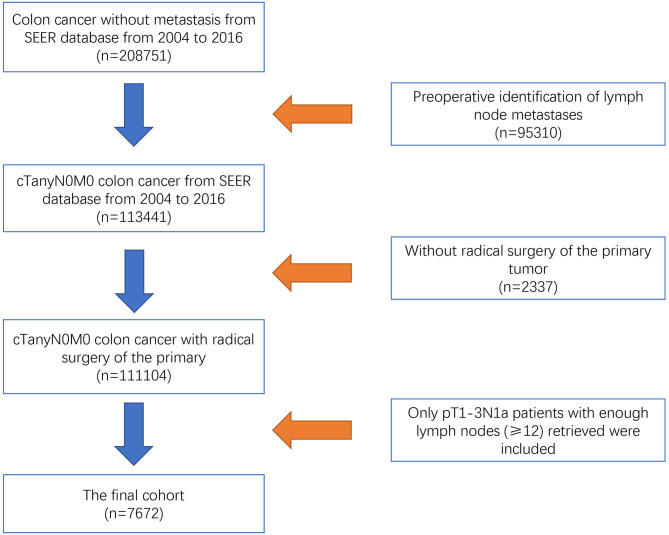
Flow chart of the selection process for pT1-3N1a colon cancer patients from the SEER database.